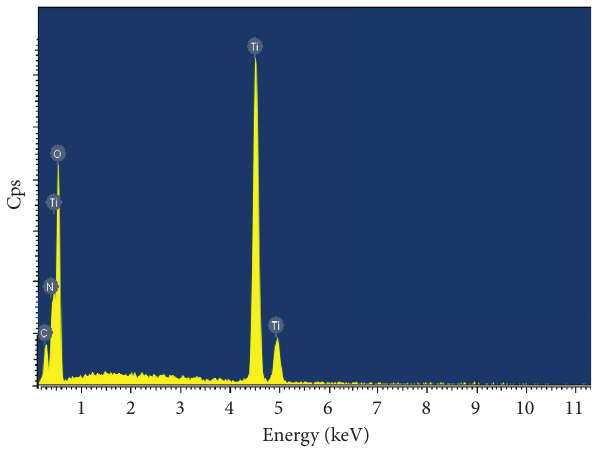
Figure 6: EDX analysis of C, N-TiO